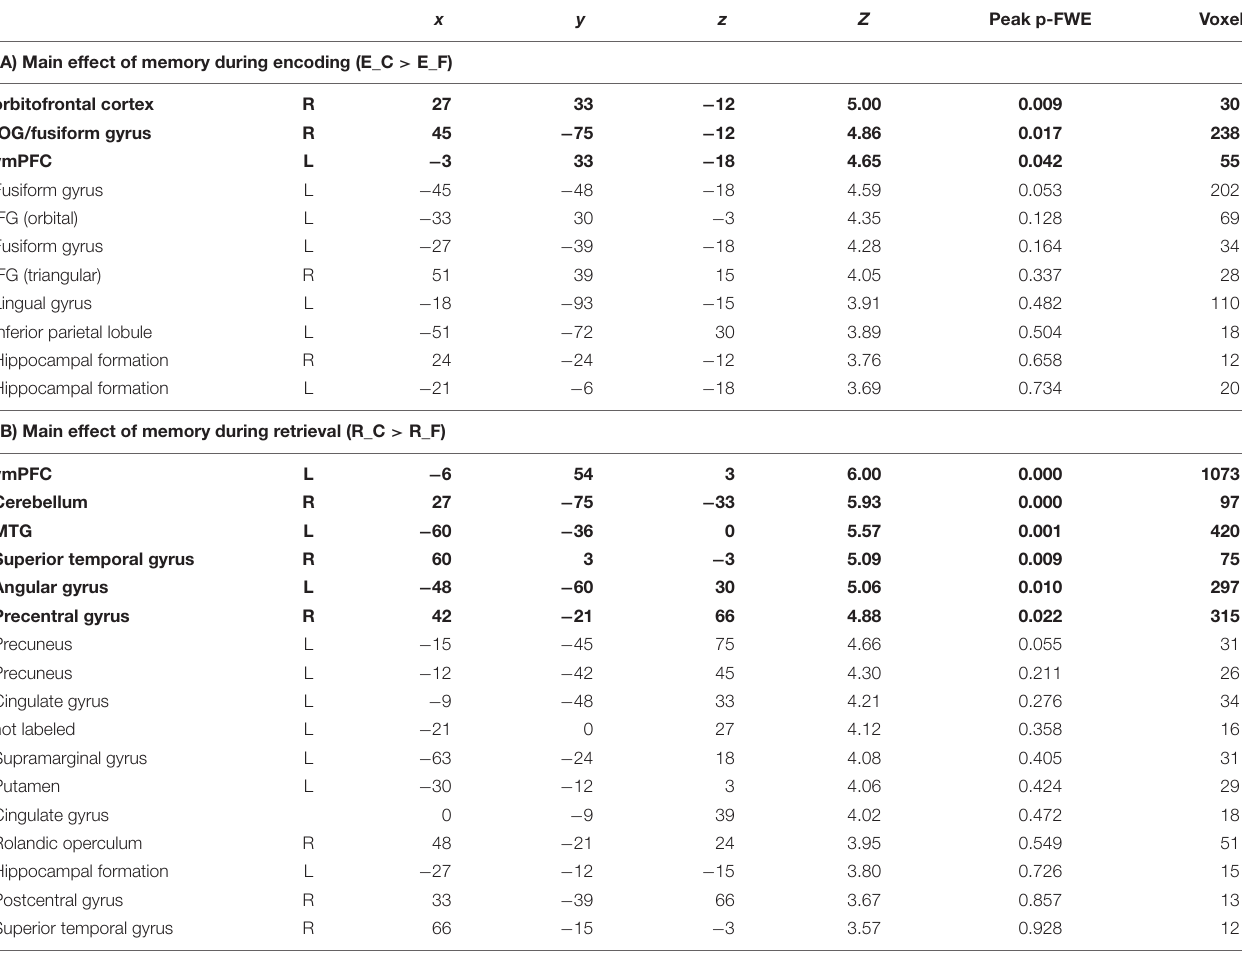
TABLE 1 | Task-related fMRI data during encoding and retrieval. x y z Z Peak p-FWE